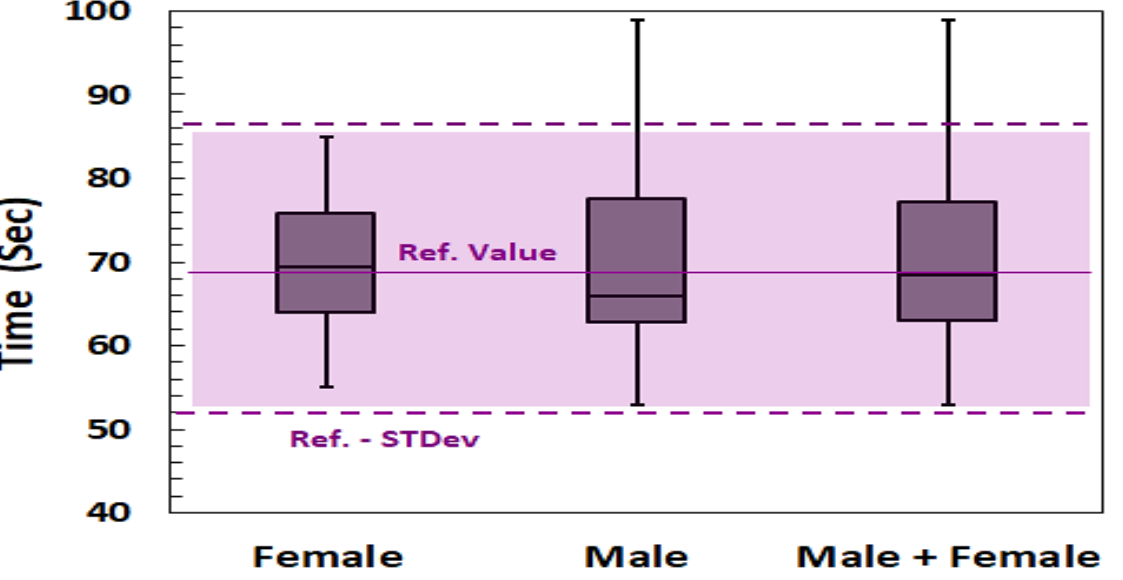
Figure 5. Box plot of measurements related to the non-dominant hands. Table 3. The measurements of time on right and left hands for some people with medical conditions. Medical Condition Right Hand